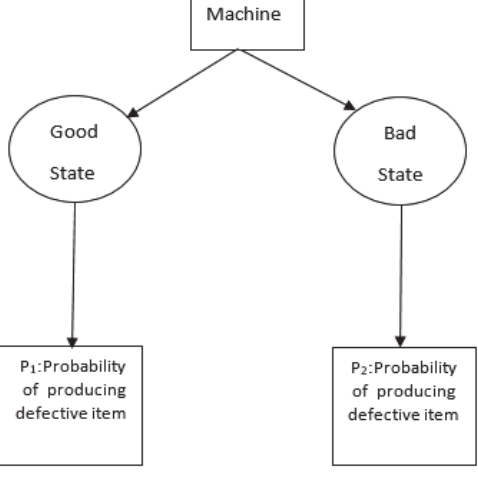
Fig. 2. Determining the parameters of the Bernoulli distribution for producing one item Parameters and formulas of the model are illustrated in following; some of them are obtained using the Bayesian inference